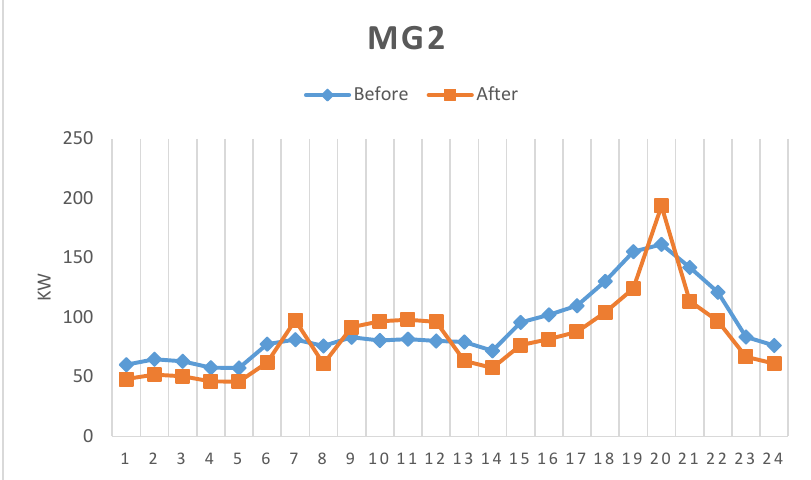
Figure 9. Consumption variations in microgrid 2: model 1.